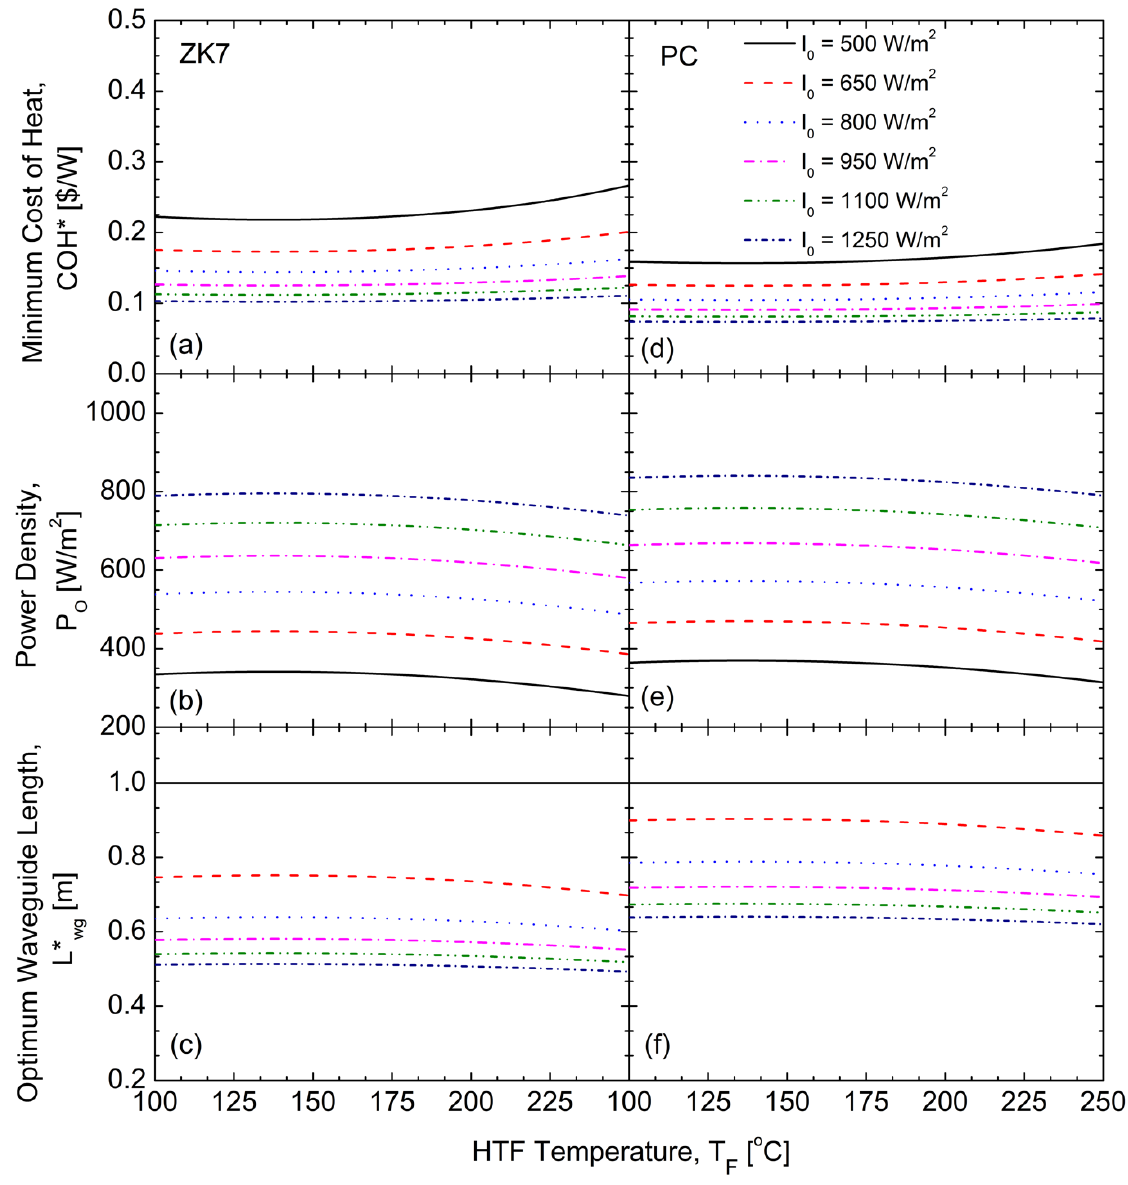
Figure 10. Numerical optimization results obtained for the minimum cost of heat objective function: Optimal waveguide length and the corresponding performance metrics obtained from numerical optimization for ( a – c ) ZK7 and ( d – f ) PC waveguide for various incident irradiation and application temperature requirement represented by 𝑇 𝐹 .